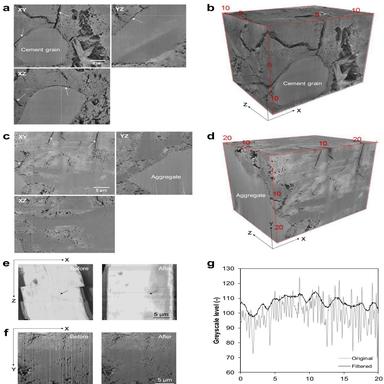
FIB-nt imaging results. a–d, Orthogonal views and 3D renderings of the reconstructed image volumes of P 0.40 cement paste (a–b) and M 0.50 mortar (c–d). Dimensions in μm. e, Alignment of the image slices based on reference lines. f, Removal of curtaining effect induced by ion-milling by wavelet-fast Fourier transform filter. g, Greyscale variation along image width of (f) before and after filtering.